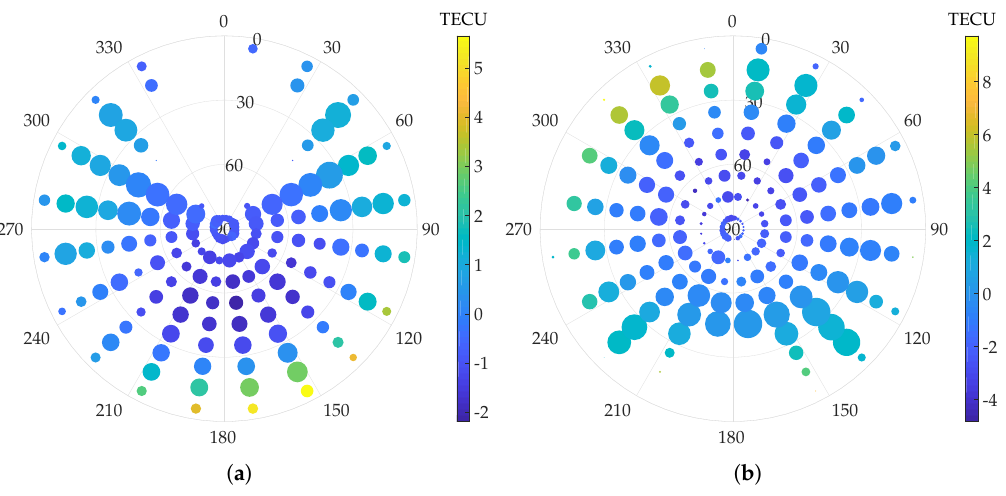
Figure 2. Azimuth and elevation dependence of post-fit IGS global ionospheric map (GIM) residuals. ( a ) A representative station from the northern hemisphere. ( b ) A representative station from the southern hemisphere. The average residual error (in TECU) is denoted by the color of the disc. The size of the disc indicates the number of samples of post-fit residuals available in each